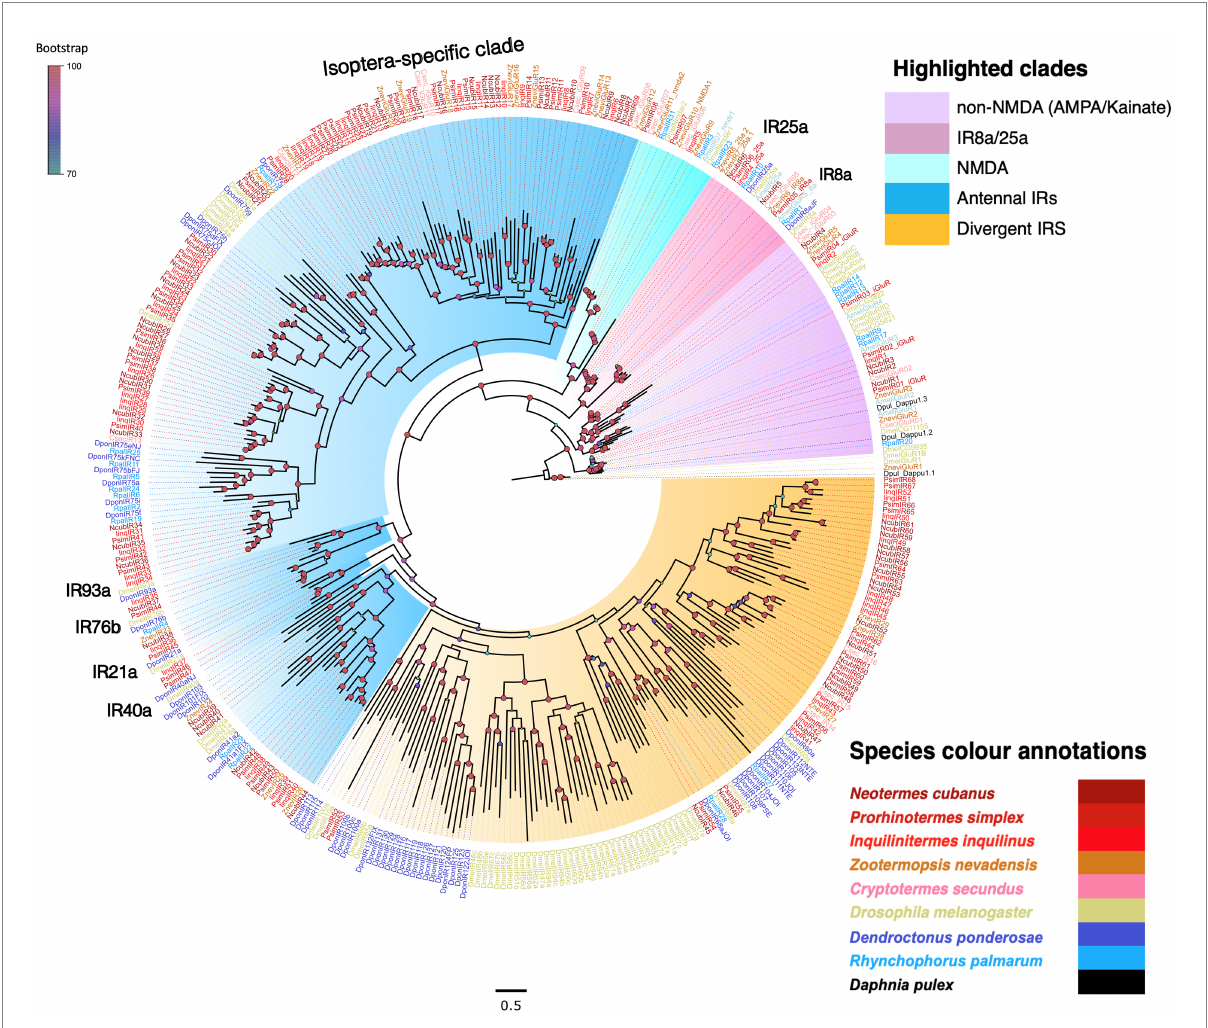
FIGURE 3 Phylogeny of termite IRs showcasing major iGluR subfamilies. The tree was reconstructed using the maximum likelihood method using LG + F + R as the best-fit amino acid substitution model and was rooted with non-NMDA iGluRs as an outgroup. Major iGluR subfamilies were highlighted as non-NMDA iGluRs (Purple), IR8a/25a (pink), NMDA (light blue), antennal IRs (blue), Divergent IRs (orange). Known conserved IR subgroups are marked in the tree. Each species represented were named as C. secundus (Csec), N. cubanus (Ncub), P. simplex (Psim), I. inquilinus (Iinq), Z. nevadensis (Znev), D. melanogaster (Dmel), D. ponderosae (Dpon), R. palmarum (Rpal), and D. pulex (Dpul). Sequence names are colored according to species and color codes are provided in the in-figure legend. The node colors indicate the bootstrap support (1,000 replicates) and the scale represents the estimated amino acid substitutions per